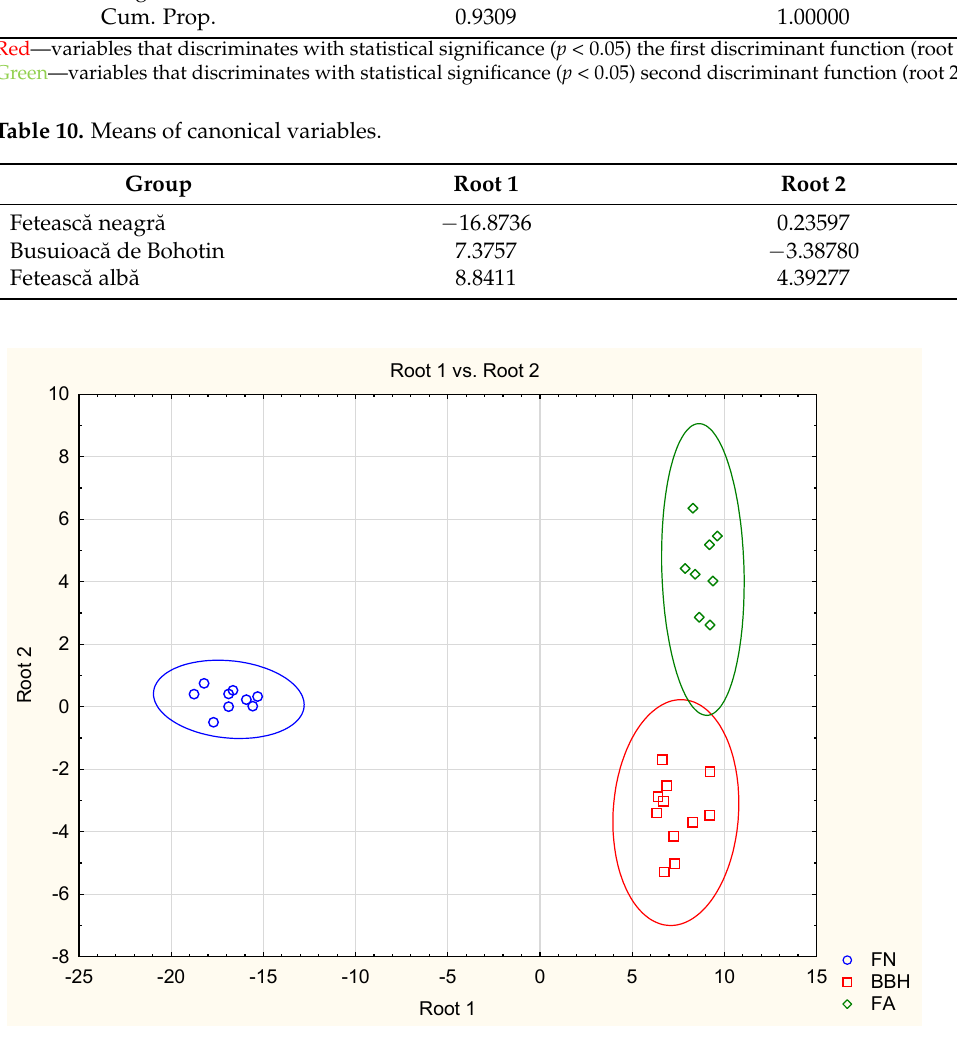
Figure 2. DFA plot of discriminating wine samples by grape variety according to the composition of the phenolic profile. the phenolic